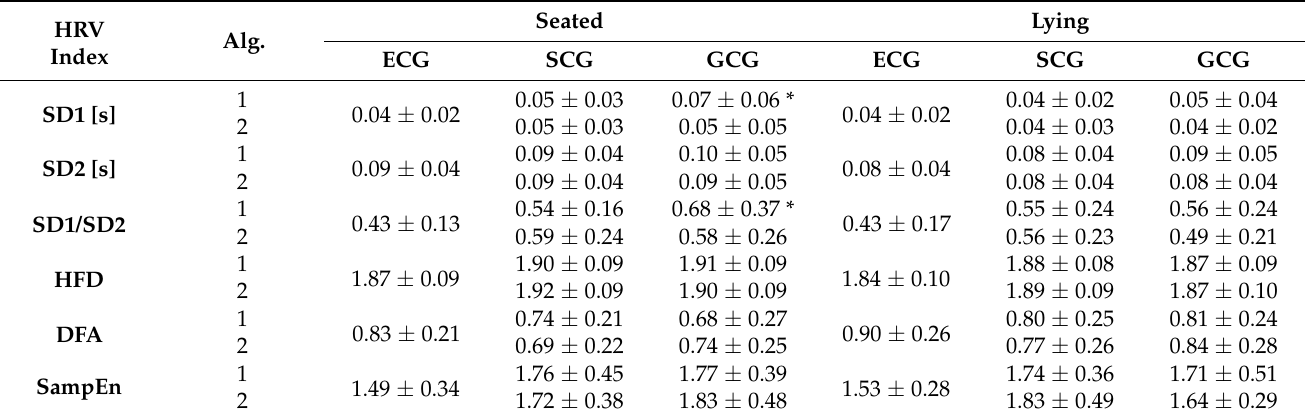
Table 3. Mean and standard deviation for all postures and subjects of HRV indexes related nonlinear measures for algorithms 1 and 2. * means statistically significant ( p <